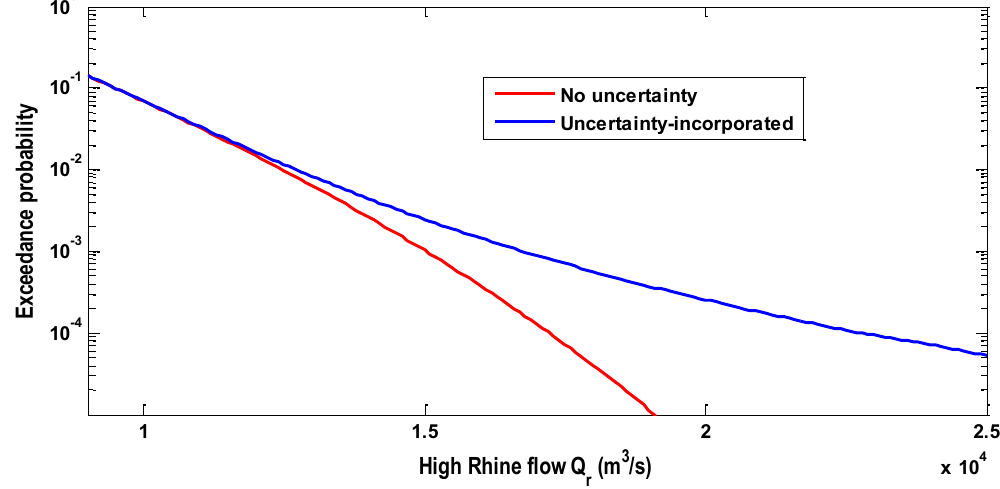
Figure 10. The uncertainty-incorporated marginal distribution of the high Rhine flow Qr .